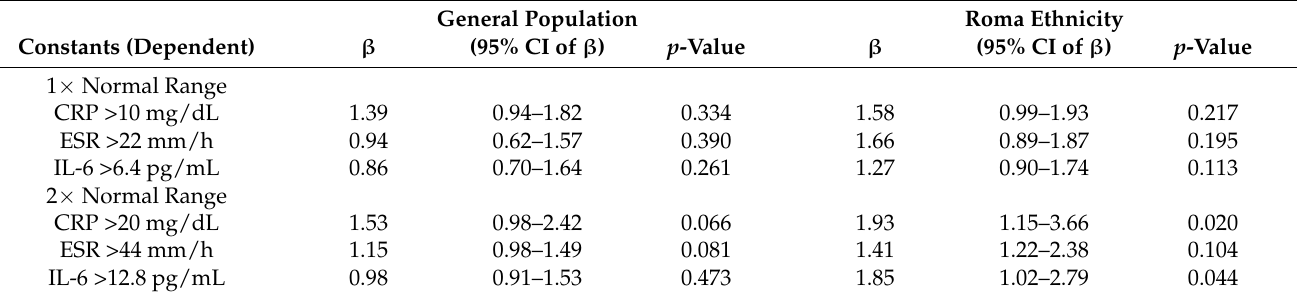
Table 6. Multivariate regression analysis in determining the influence of ethnicity for elevated inflammatory markers.